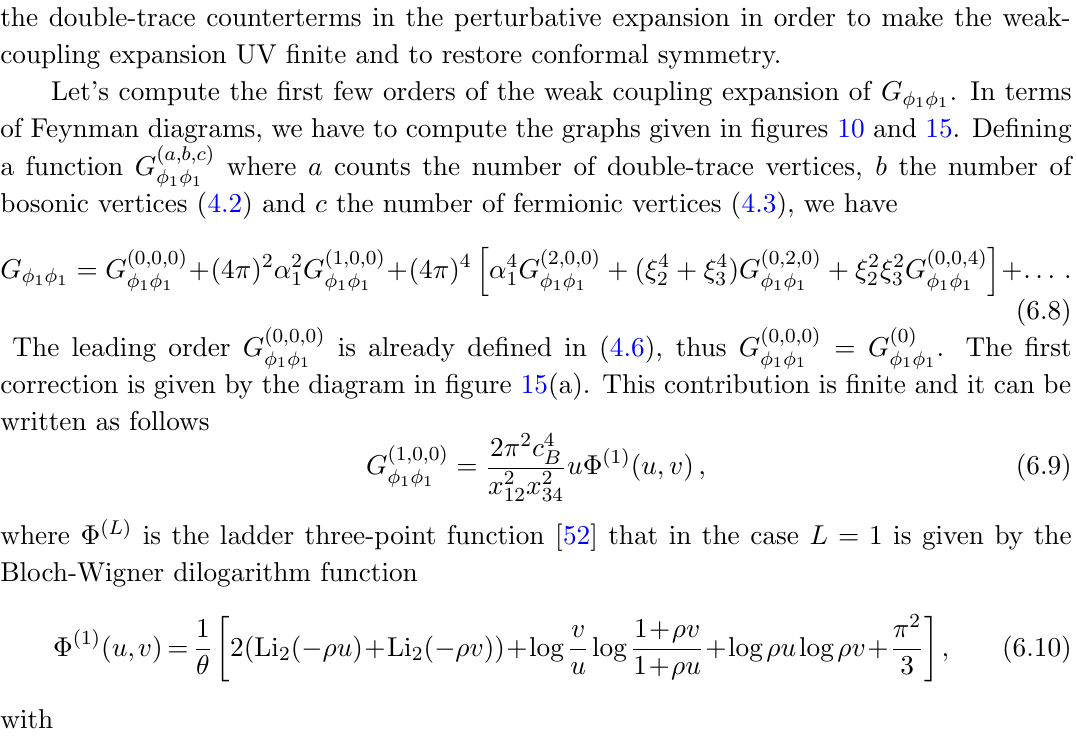
Figure 15 . First two contributions of the double trace vertex Tr[ (cid:30) 1 (cid:30) 1 ]Tr[ (cid:30) y functions G (cid:30) 1 (cid:30) 1